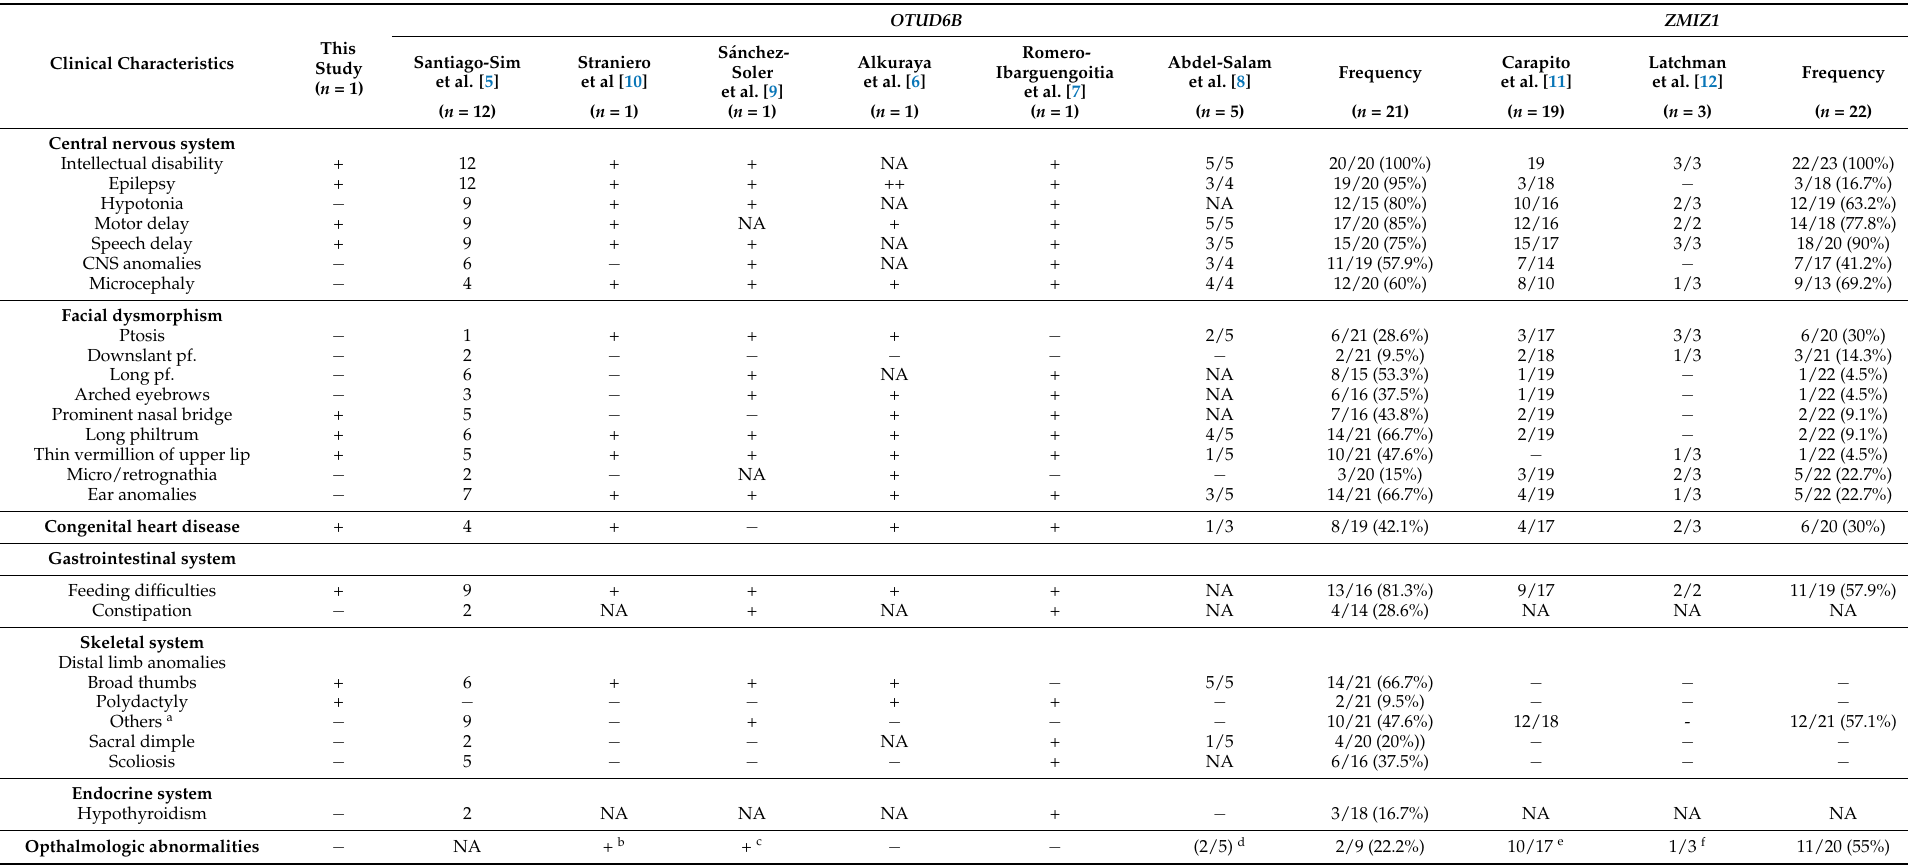
Table 1. Comparison of clinical characteristics of the present patient and those of OTUD6B - and ZMIZ1 -related intellectual